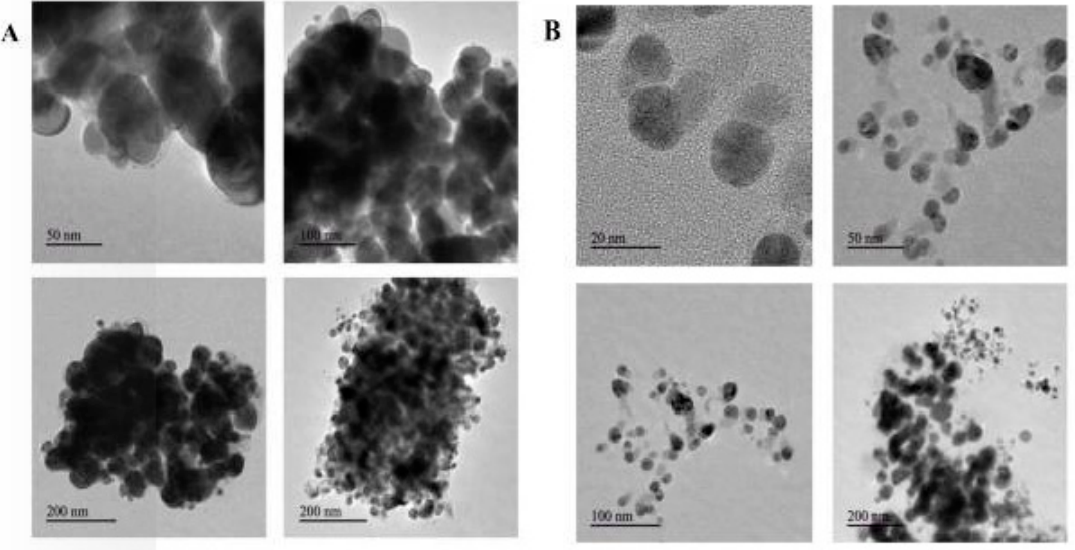
Figure 6. Transmission electron microscopy (TEM) images of biosynthesized silver nanoparticles from ( A ) Catharanthus roseus and ( B ) Azadirachta indica plant extracts.